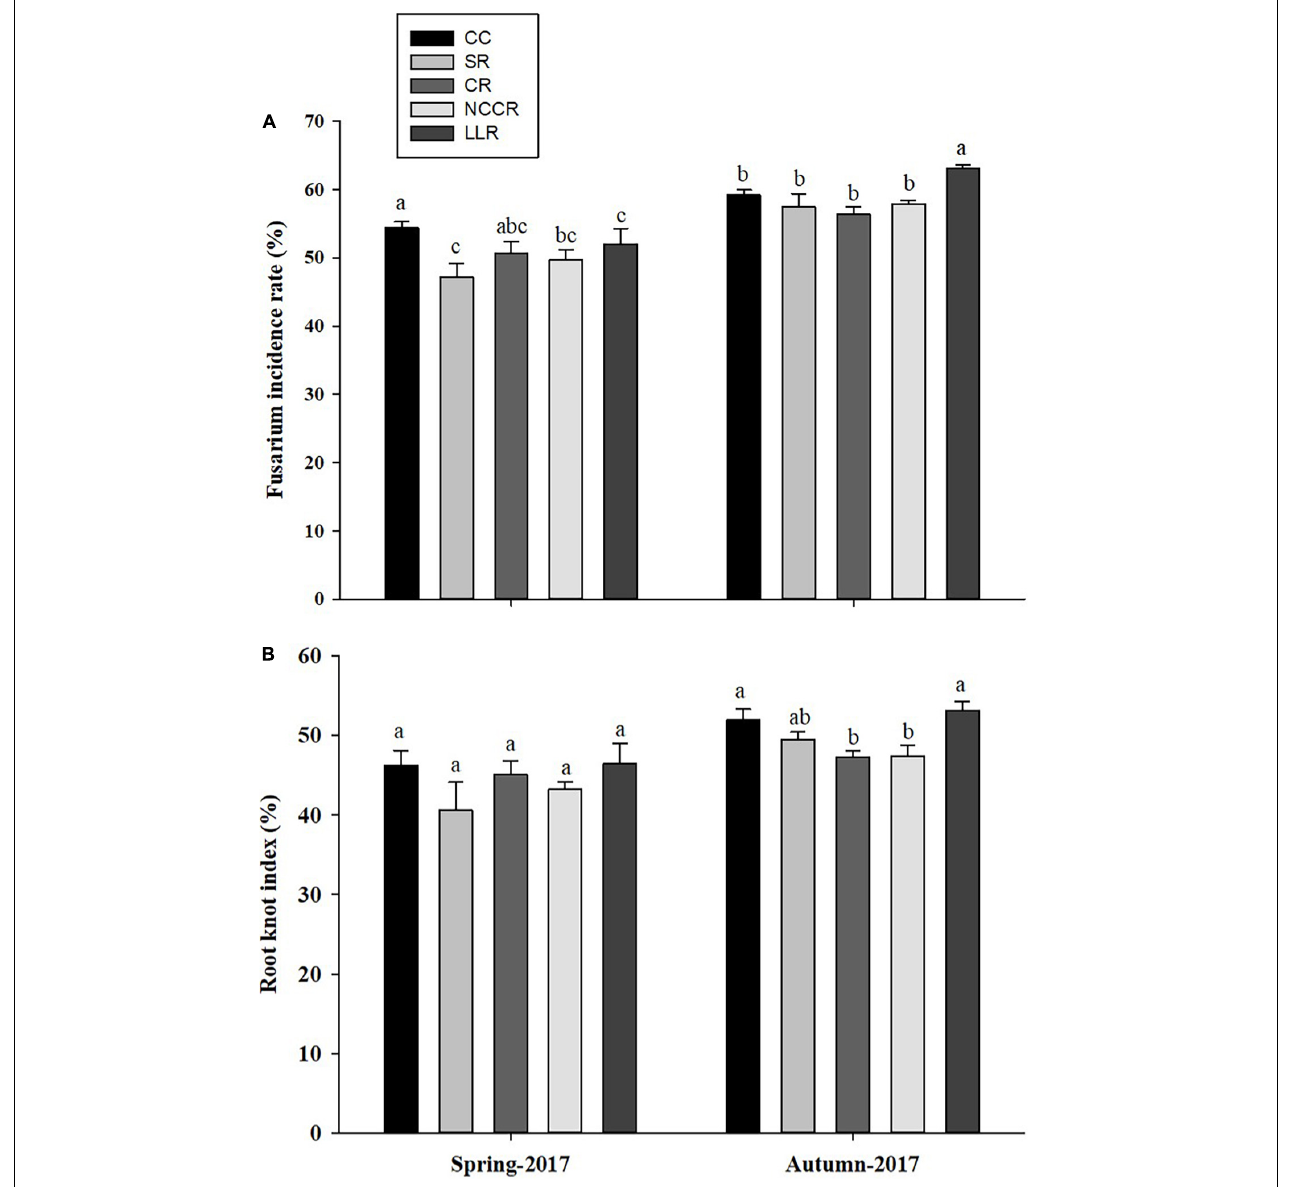
FIGURE 1 | Effects of different cropping treatments on replant disease incidence (%) of cucumber plants during two growing seasons: Fusarium wilt incidences (A) and Root-knot index (B) . Different letters indicate significant differences in different treatments ( p < 0.05). CC (continuous cucumber); SR (spinach rotation); CR (coriander rotation); NCCR (non-heading Chinese cabbage rotation); and LLC (leafy lettuce